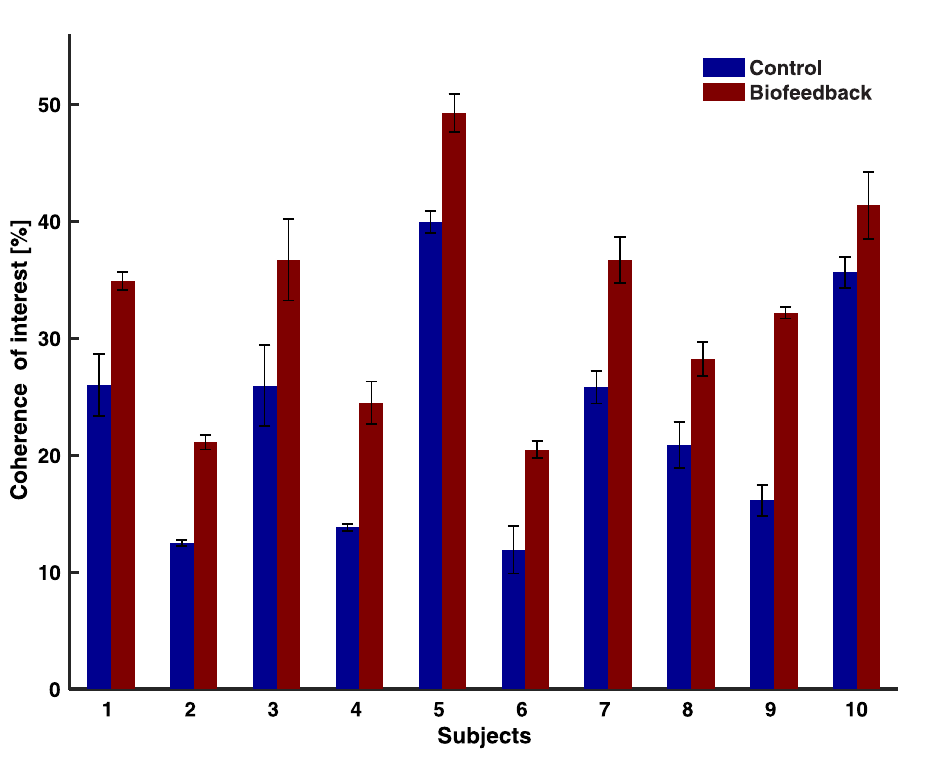
Fig 8. Mean ± SEM (3 trials per condition) coherence of